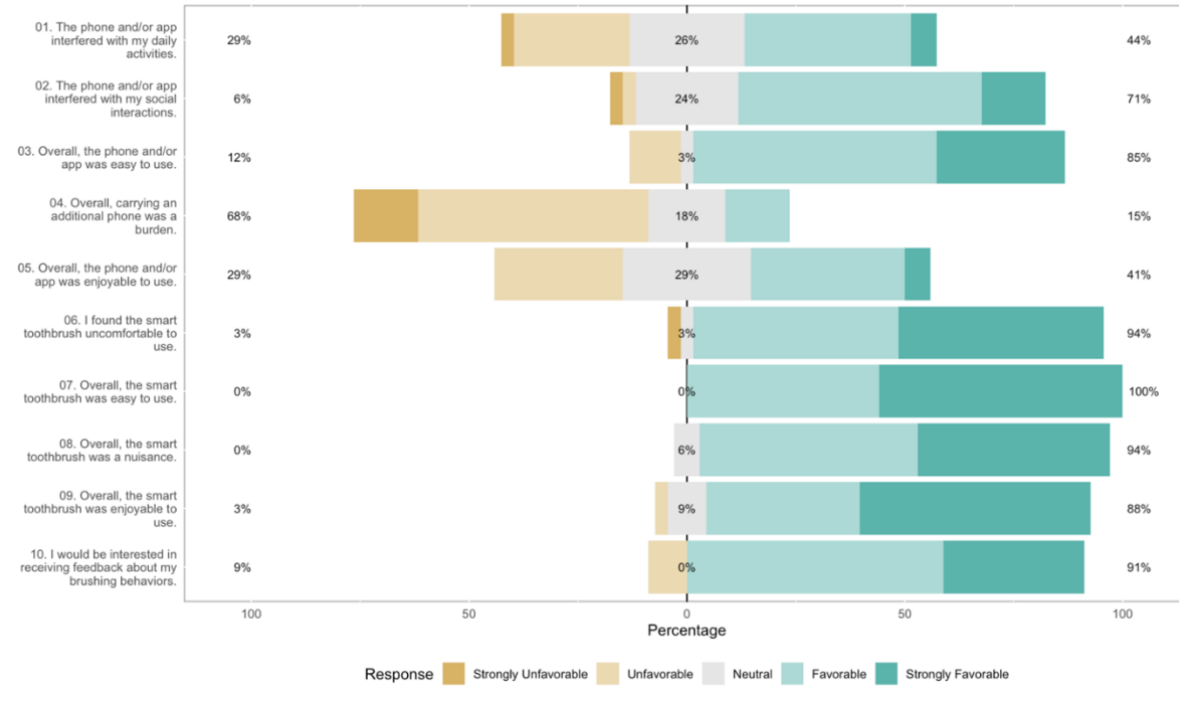
Figure 8. Exit interview usability survey responses; the percentages of negative, neutral, and positive responses are printed on the left, center, and right, respectively, of each color